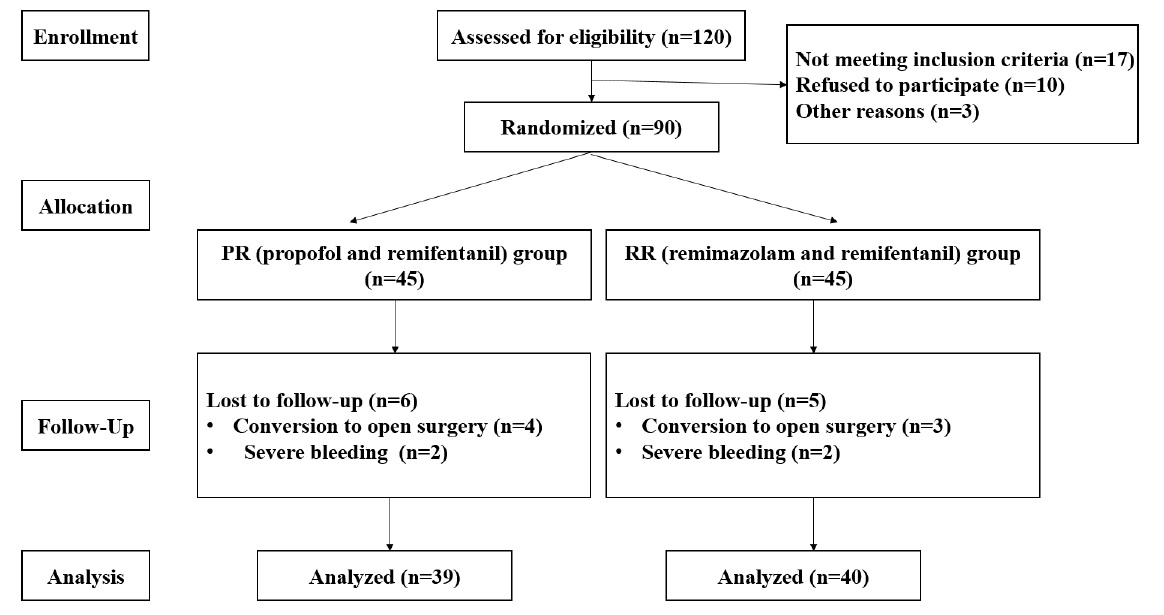
Figure 1. Consort flow diagram. The vasoconstriction threshold was significantly higher in the RR group (35.2 ± 0.4 °C) than in the PR group (34.8 ± 0.3 °C) ( p < 0.01, 95% confidence interval (CI): −0 .5 to −0 .2). The time to onset of vasoconstriction was significantly shorter in the RR group (150.5 ± 10.2 min) than in the PR group (158.5 ± 8.4 min) ( p < 0.01, 95% CI: 3.8 – 12.2) (Table 1 and Figures 2 and 3). The core body temperature in the RR group was significantly higher at 60, 80, 100, 120, 140, 160, and 180 min after induction than in the PR group ( p < 0.01) (Figure 4). The Table 1. Demographic and intraoperative